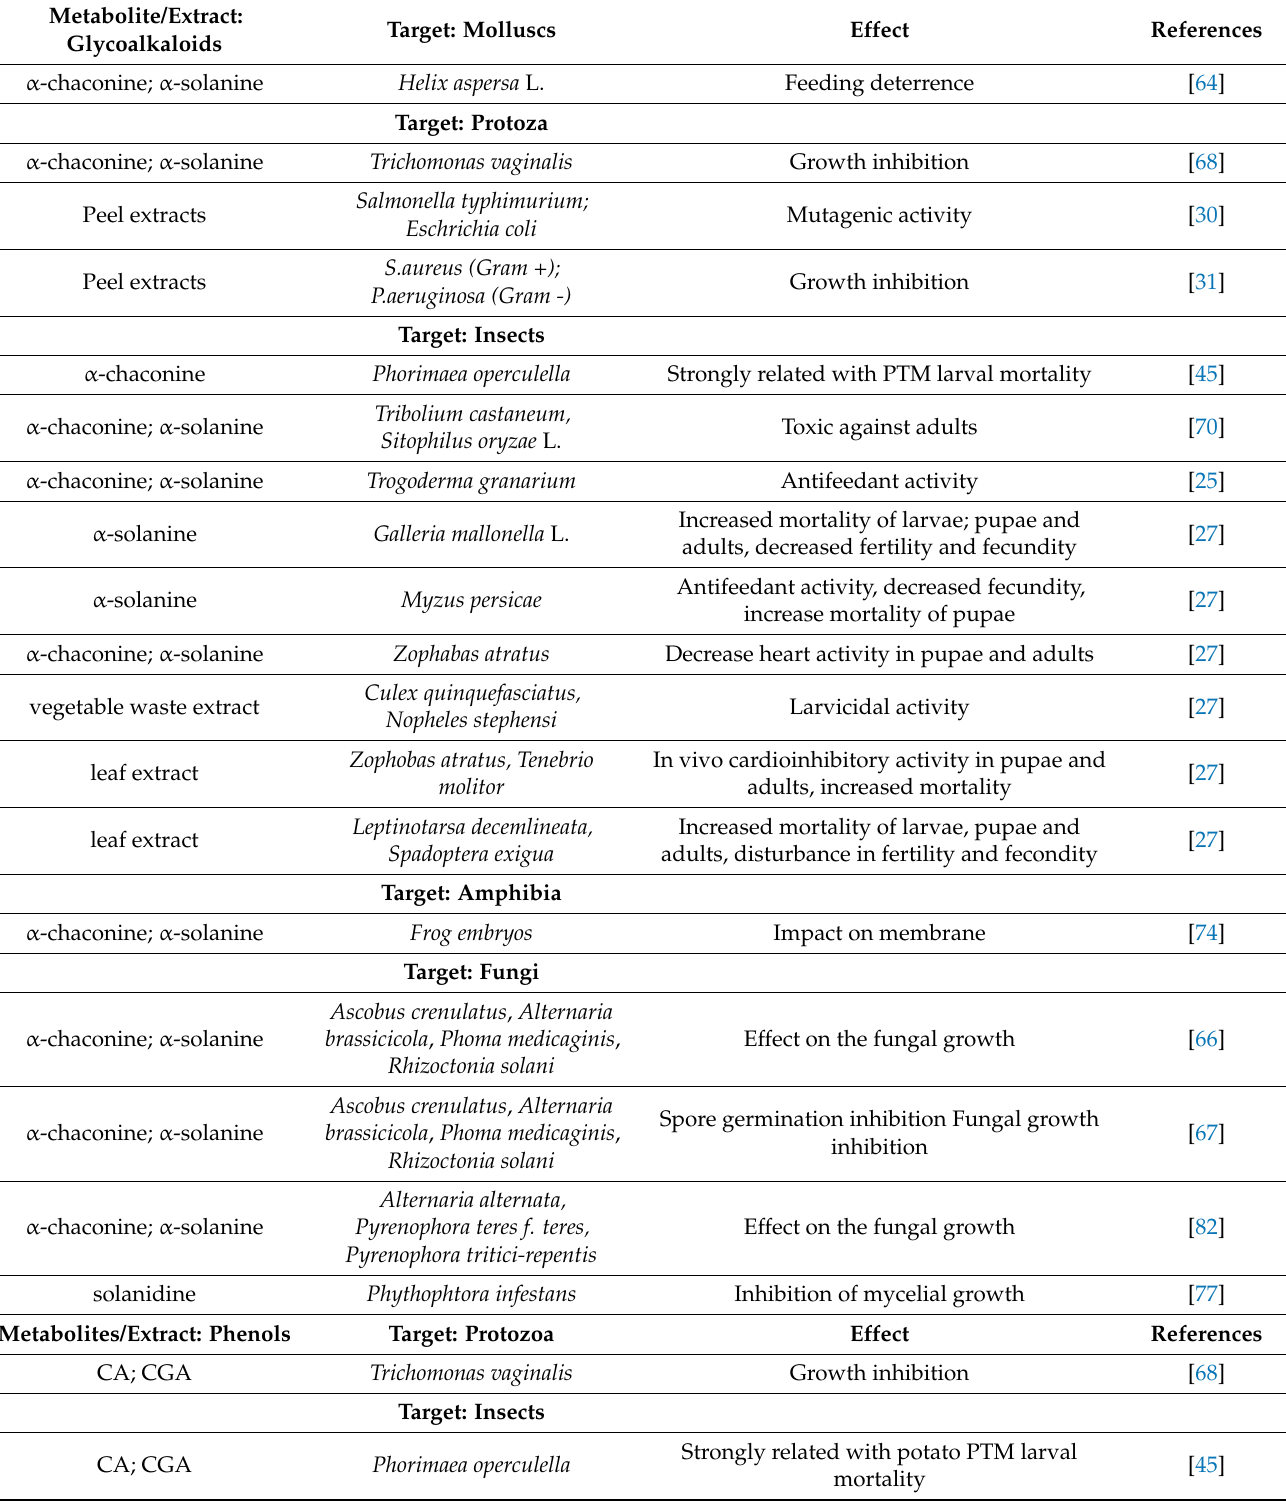
Table 1. Potato metabolites activity against biotic